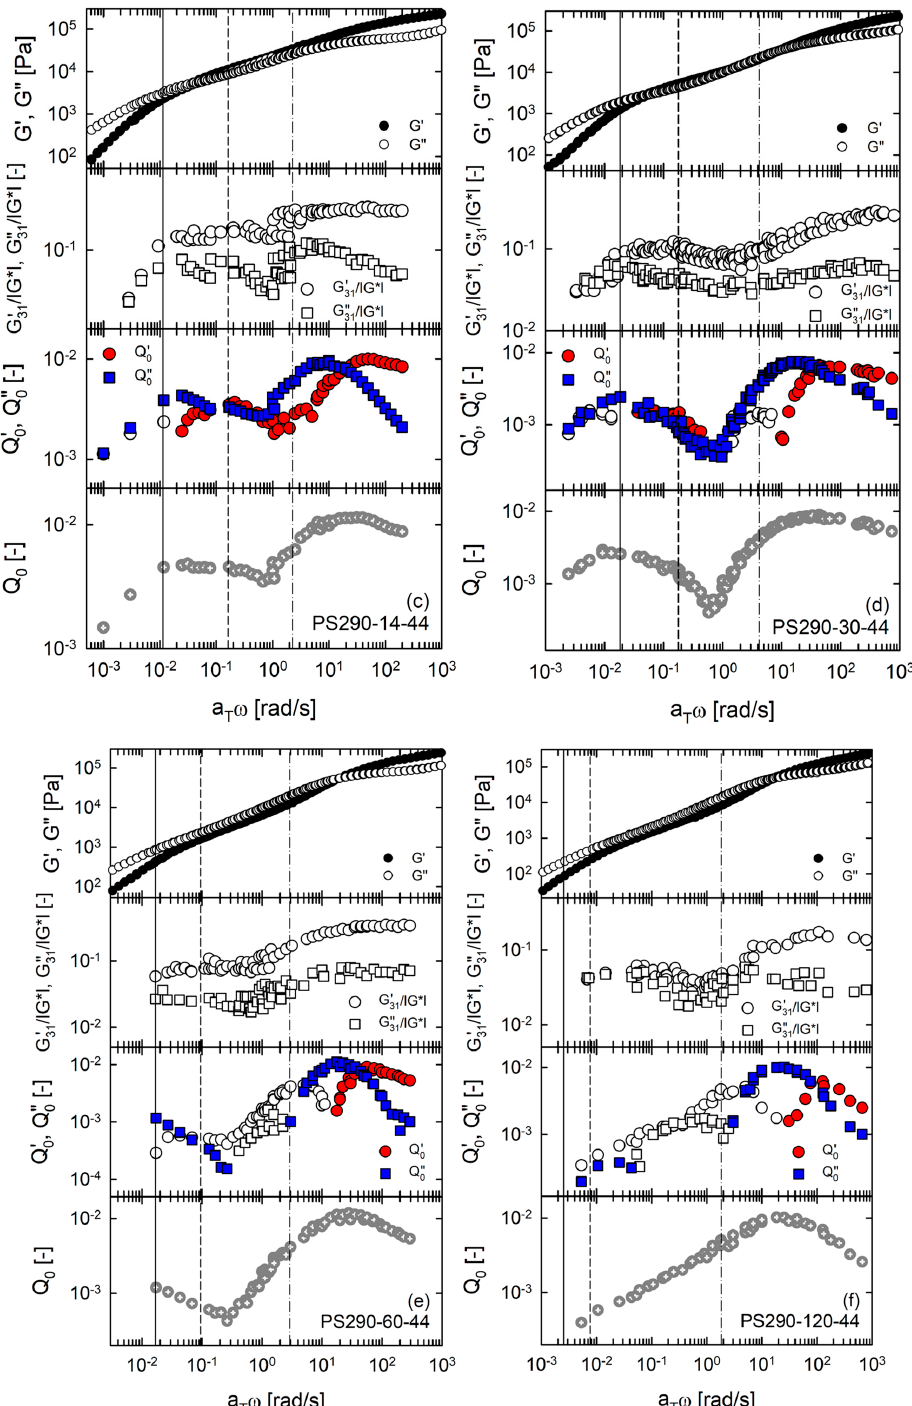
Figure 9. Comparison of linear and nonlinear master curves of model comb PS set with characteristic relaxation times. The solid line indicates the terminal relaxation timescale ( τ L ). The dashed line indicates the backbone Rouse timescale ( τ R,bb ). The dash-dot line indicates the branch relaxation timescale ( τ br ).